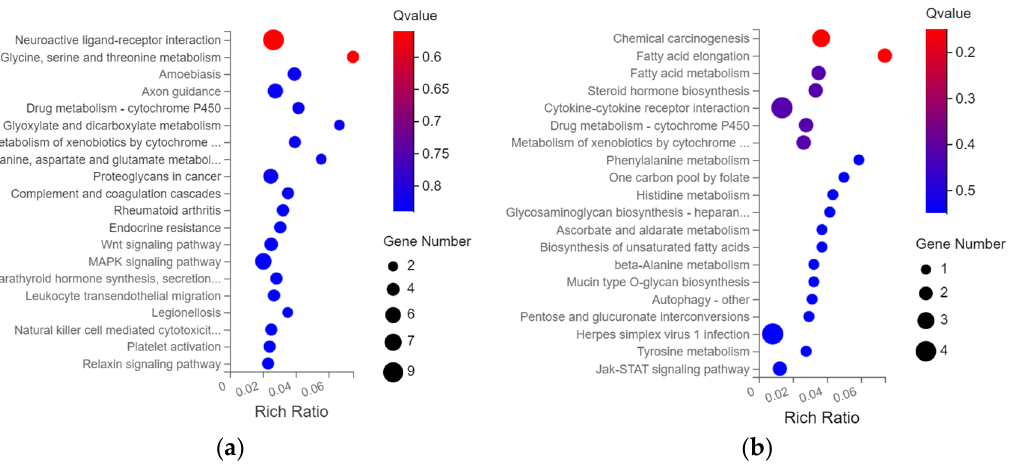
Figure 5. KEGG enrichment analysis. Usually, Qvalue ≤ 0.05 was considered significantly enriched. ( a ) up − regulated gene; ( b ) down − regulated gene. GJL vs. DZ of HacaT cells. ( a ) up-regulated gene; ( b ) down-regulated gene. GJL vs. DZ of HacaT